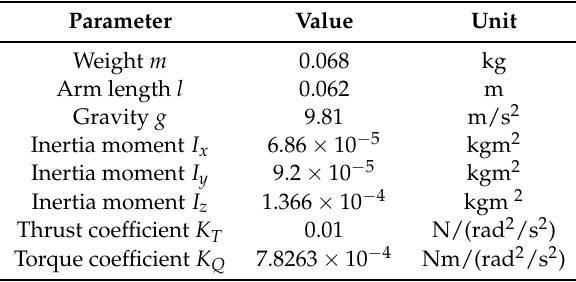
Table 1. Quadrotor MAV model parameters